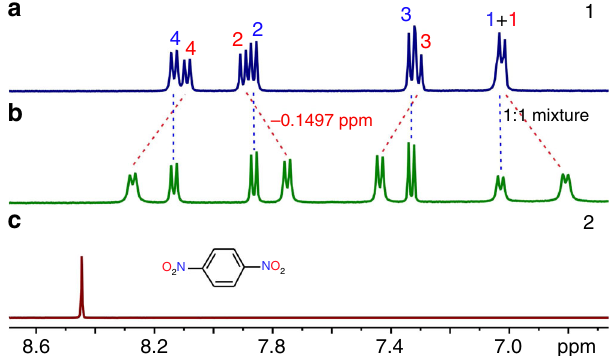
Fig. 3 Host-guest binding between macrocycle 1 and guest 2. Partial 1 H NMR spectra (500 MHz, CD 2 Cl 2 , 2.0 mM, 25 °C) of ( a ) 1 , ( c ) 2 and ( b ) their 1:1 mixture. The colors of the numberings on the NMR peaks are the same as those on the structures of the conformations (Fig.